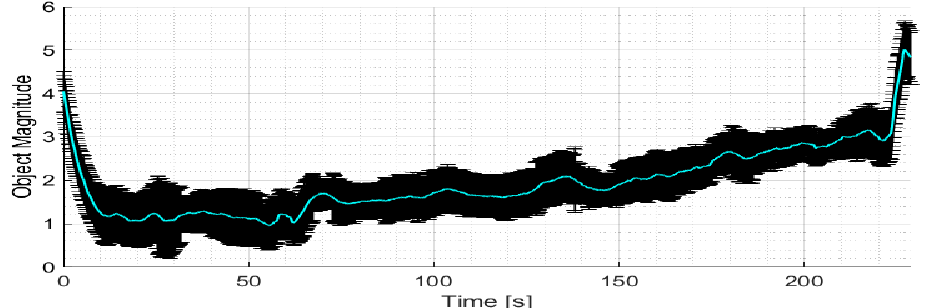
Figure 7. Observed light-curve not normalized of CZ-4C (SSN 40879) taken the 22nd of July 2020 from SCUDO observatory.